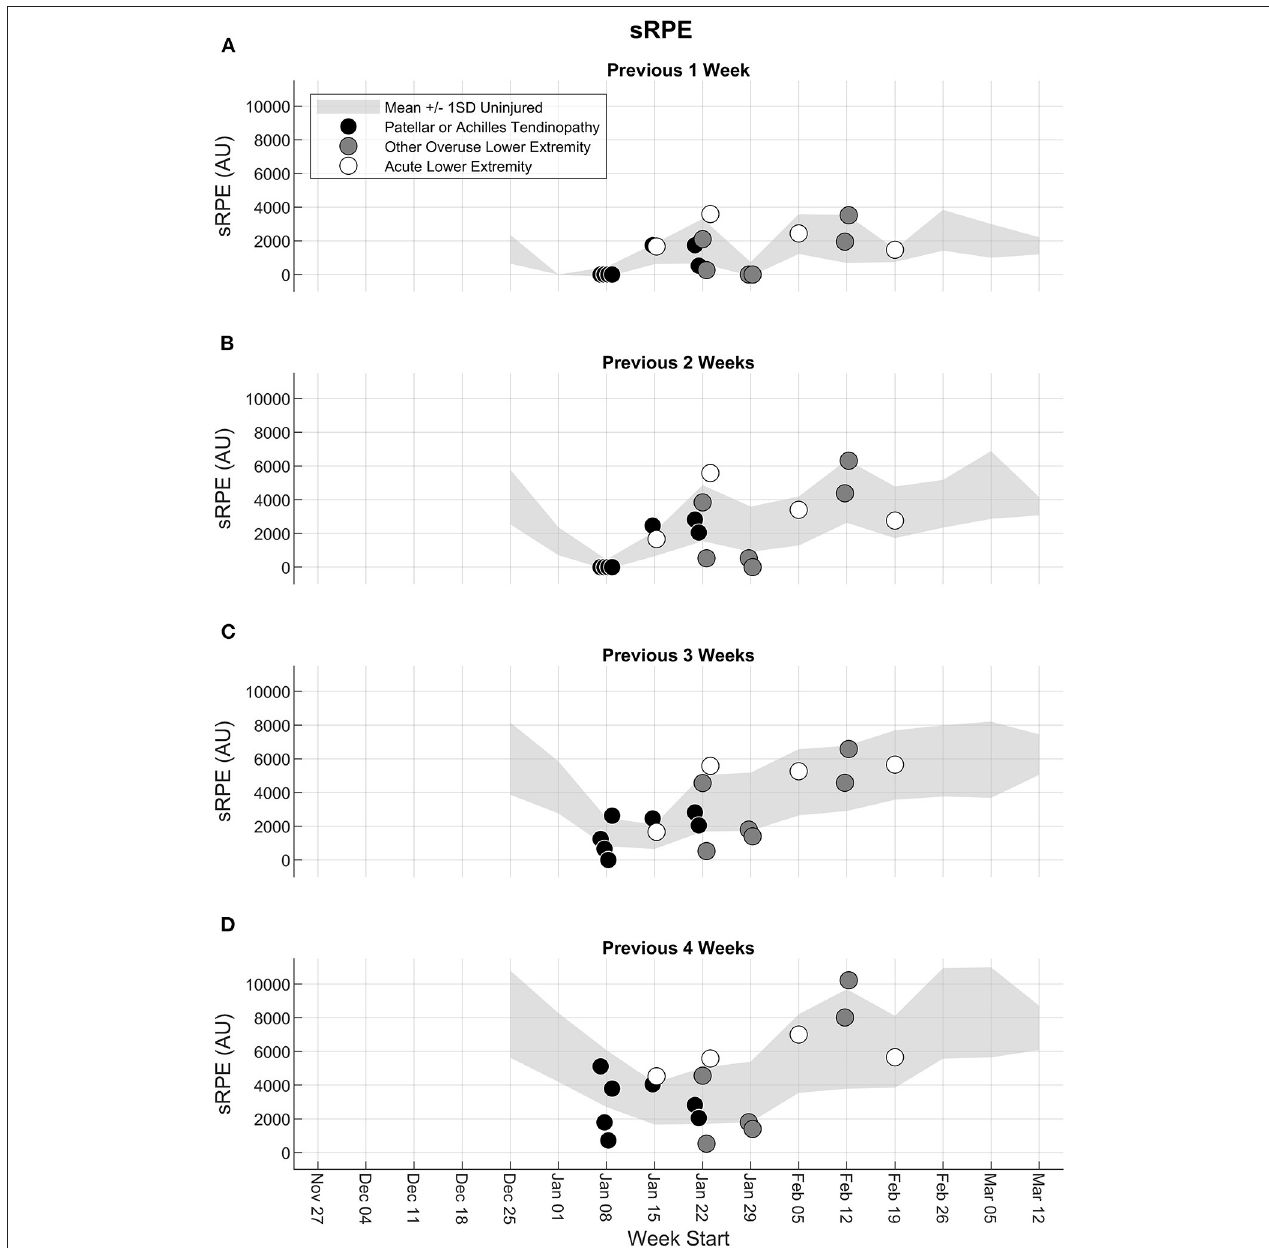
FIGURE 6 | Accumulated sRPE from the fifth week to the end of the season for the previous (A) 1 week, (B) 2 weeks, (C) 3 weeks, and (D) 4 weeks. Light gray shaded band represents the mean ± 1 standard deviation (SD) of all participants until the last week where they did not experience any injury. Participants with a lower extremity injury are shown separately in the week in which their first injury was reported, and the injury type is indicated as patellar or Achilles tendinopathy (black circle), other overuse lower extremity injury (dark gray circle), or acute lower extremity injury (white circle).